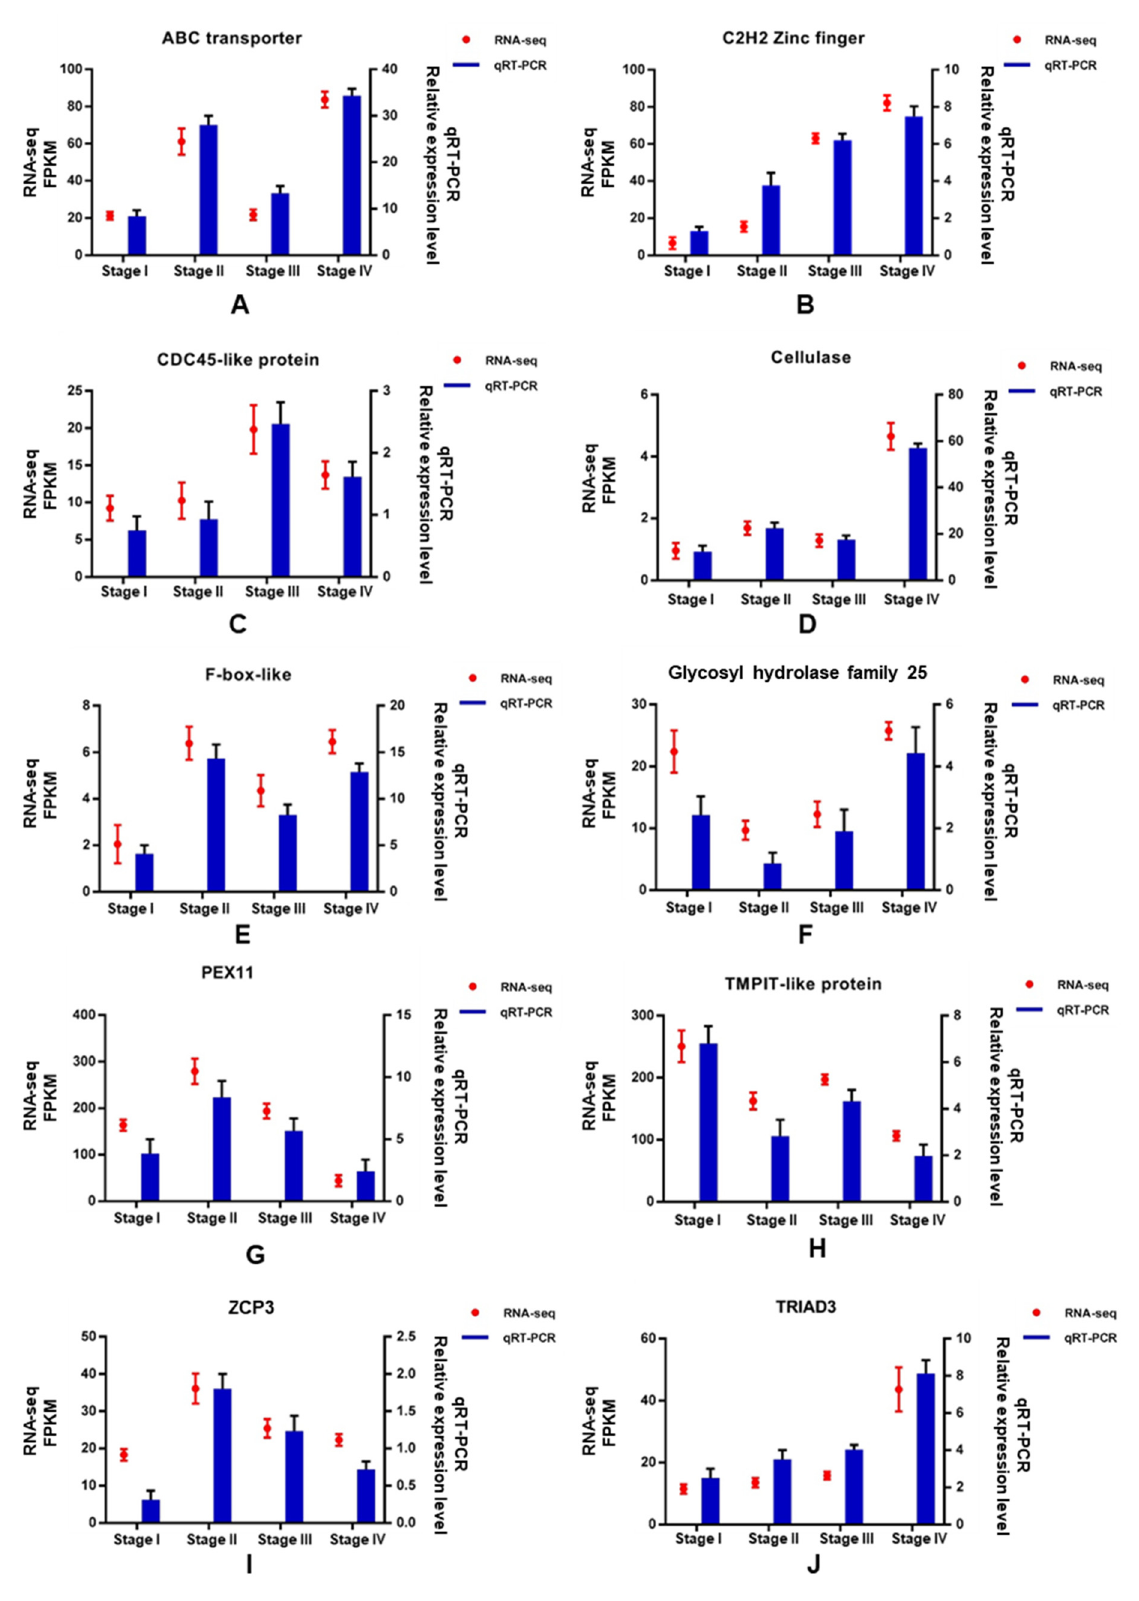
Figure 9. qRT-PCR results of 10 DEGs.